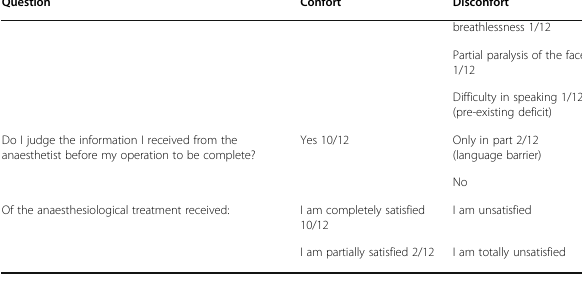
Abstract 71. Enhanced recovery pathways for video-assisted thoracoscopic surgery (VATS): an experience from Maggiore Hospital, Bologna Scardua J. 1 , Santarelli S. 2 , Degli Esposti E. 1 , Solli P. 3 , Brandolini J. 3 ,